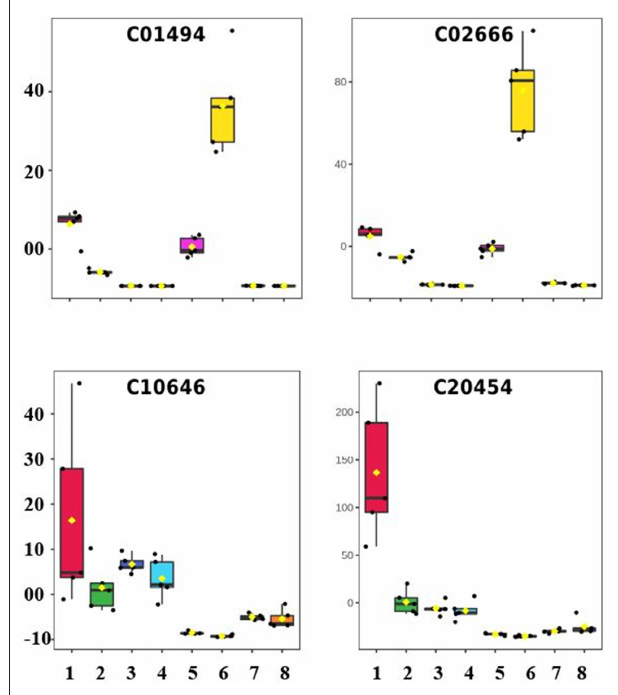
FIGURE 6 | Box plot showing the normalized concentration of metabolites in the leaves and roots of young gliricidia plants submitted to salt stress. (The expression profiles of Ferulic acid (C01494), Coniferyl aldehyde (C02666) ( + )-Lariciresinol (C10646), and (–)-Lariciresinol (C20454) in the following treatments: 1—C_L02D, 2—C_L55D, 3—C_R02D, 4—C_R55D, 5—S_L02D, 6—S_L55D, 7—S_R02D, 8—S_R55D, where C—Control, S—Stressed, F—Leaves, R—Roots, 02D—short-term stress, and 60D—long-term